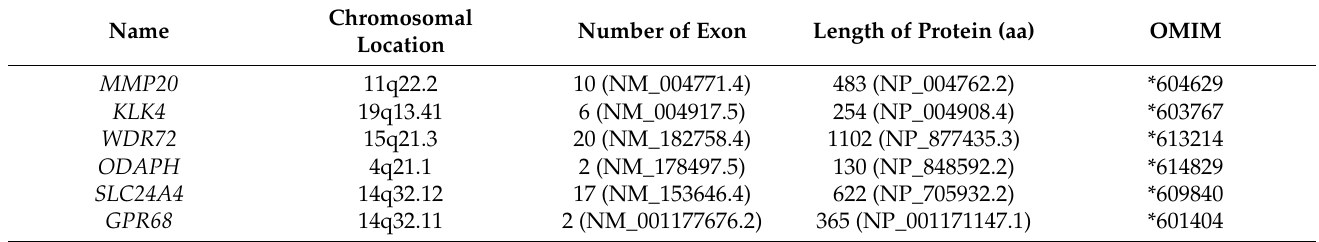
Table 1. Genes causing autosomal recessive hypomaturation